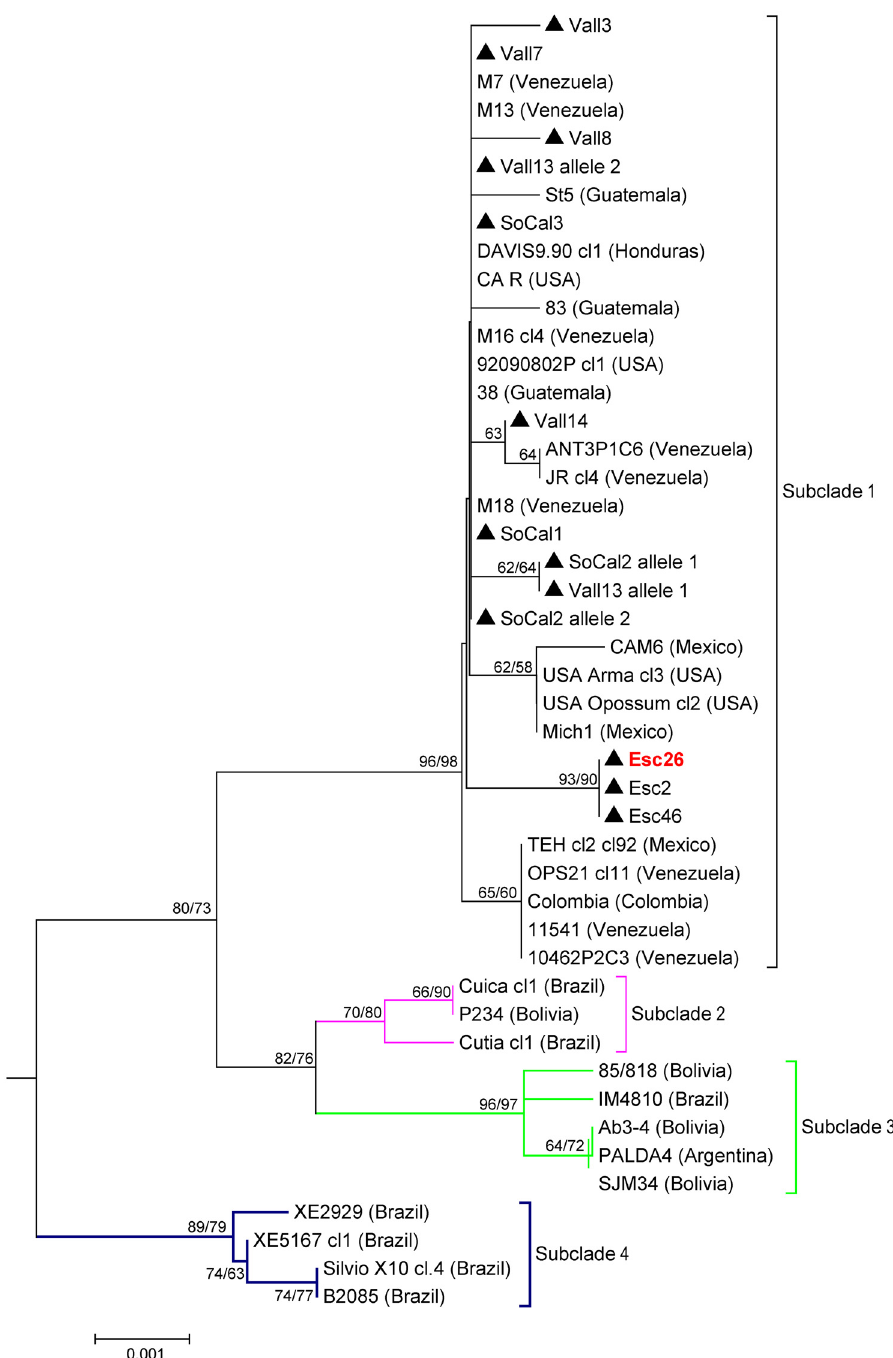
Fig 5. TcI subtree represented as TcI on Fig 4 showing four distinct subclades. This subtree includes 46 COII-ND1 concatenated sequences (786 bp). The scale bar indicates the number of nucleotide substitutions per site for the NJ tree. The numbers above or below the nodes represent the bootstrap confidence levels for 2,000 NJ replicates (1 st value) and 500 Maximum Likelihood replicates run under the Tamura 3-parameter model. Only bootstrap values (cid:1) 50% are shown. Sequences obtained in this study are indicated by the triangles (Esc = Escondido, SoCal = Southern California, Vall = Vallecito). Esc26 was grouped with TcI in this analysis but was grouped with TcIV in all other analyses. All other isolates represent published GenBank sequences as listed in S1 Table with their country of origin indicated in